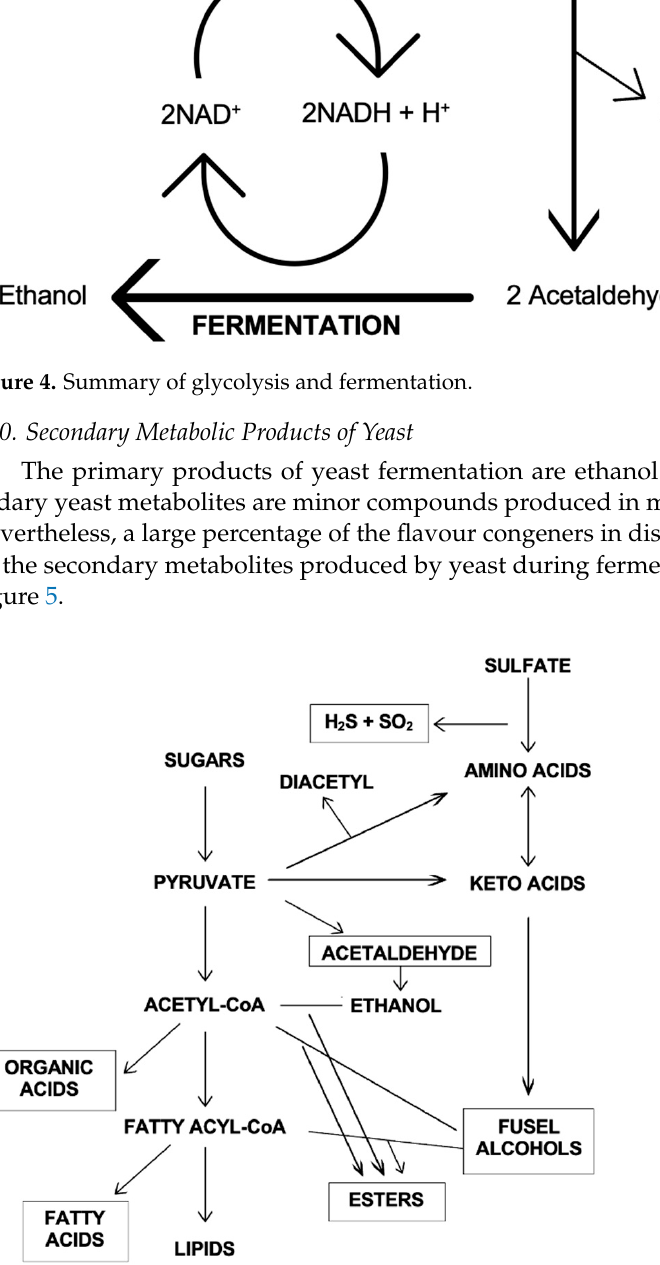
Figure 5. Outline of metabolic inter-relationships in the synthesis of secondary yeast metabolites.